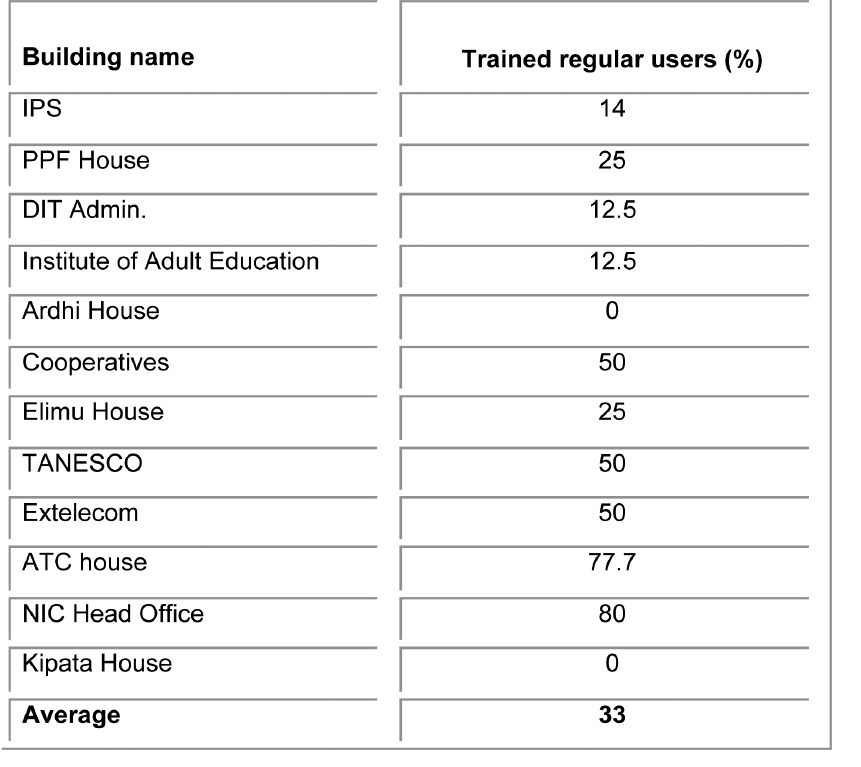
Table 6. Training of workers/regular users on fire and